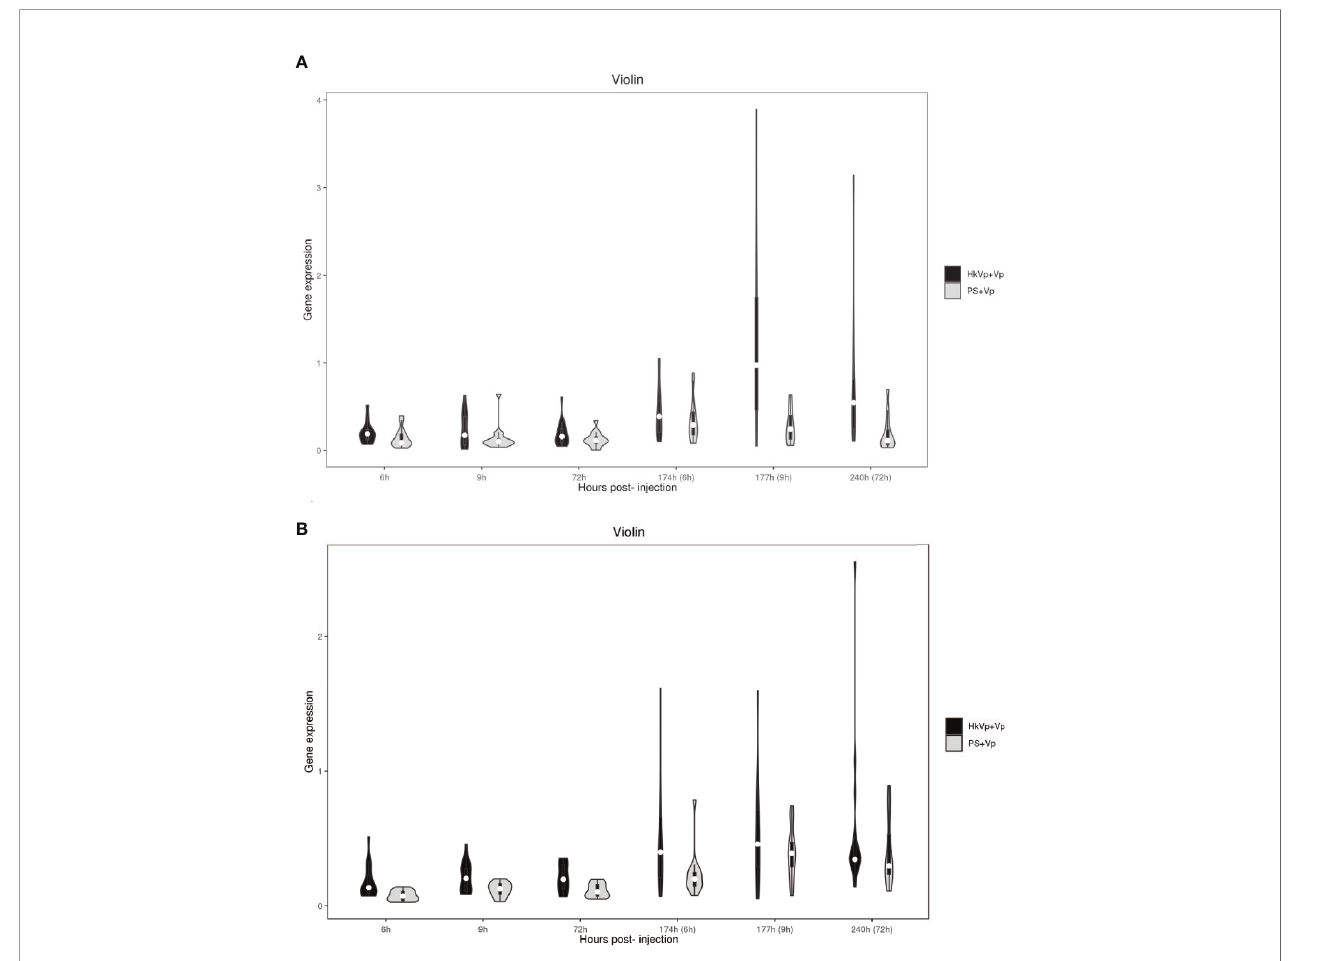
FIGURE 4 | Violin plots representing mRNA expression of genes of members of the TLR signaling pathway and AMPs. (A) mRNA expression of genes in the hepatopancreas in the HkVp+Vp group compared with that in the PS+Vp group. (B) mRNA expression of genes in hemocytes in the HkVp+Vp group compared with that in the PS+Vp group. The x -axis denotes the hours after bacterial injection [IPP (6, 9, and 72 h) and the ICP (174, 177, and 240 h)]. The y -axis represents expression of genes of members of the TLR signaling pathway and